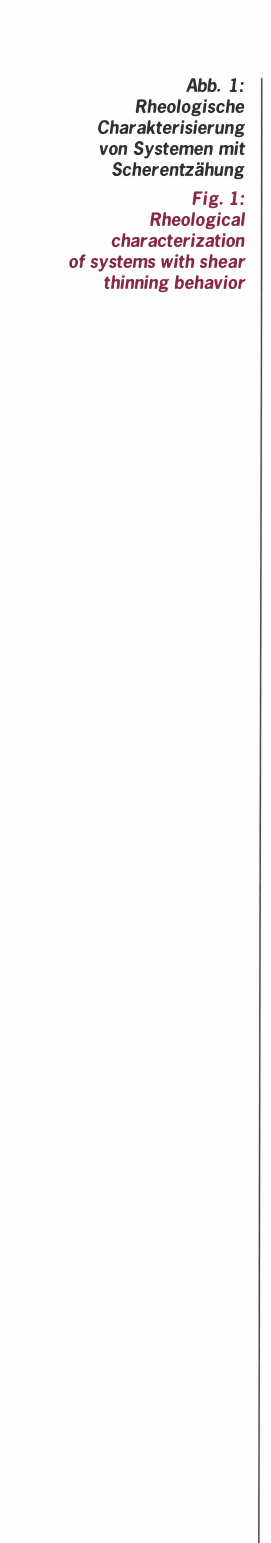
Flow curves of the silicon oil M20'000